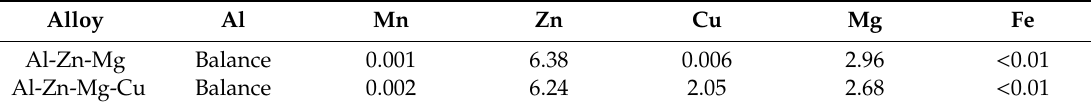
Table 1. Chemical composition determined by ICP-OES (wt.%).